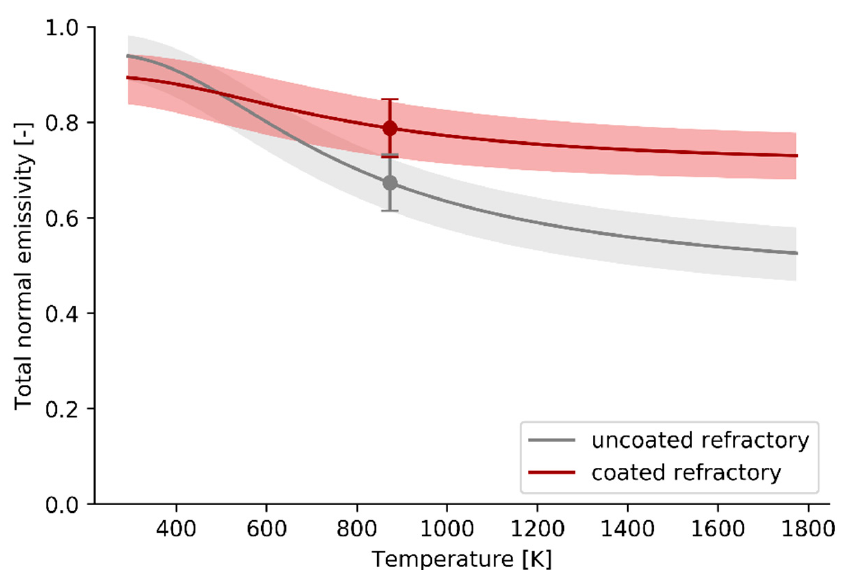
Figure 6. Total normal emissivity results for uncoated refractory and coated refractory calculated based on the spectral normal emissivity measurements performed at 873 K.